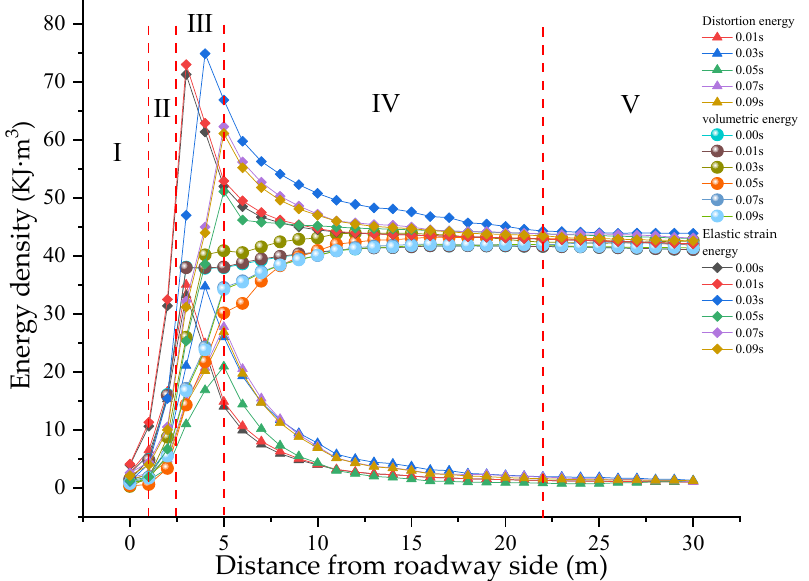
Figure 6. Dynamic Evolution Curves of the Energy Density of Surrounding Rock under Dynamic Load Disturbance. ( Ⅰ –broken zone; II– original plastic zone; III– newly added plastic zone; IV –elastic zone; V– stress zone of primary rock ) .